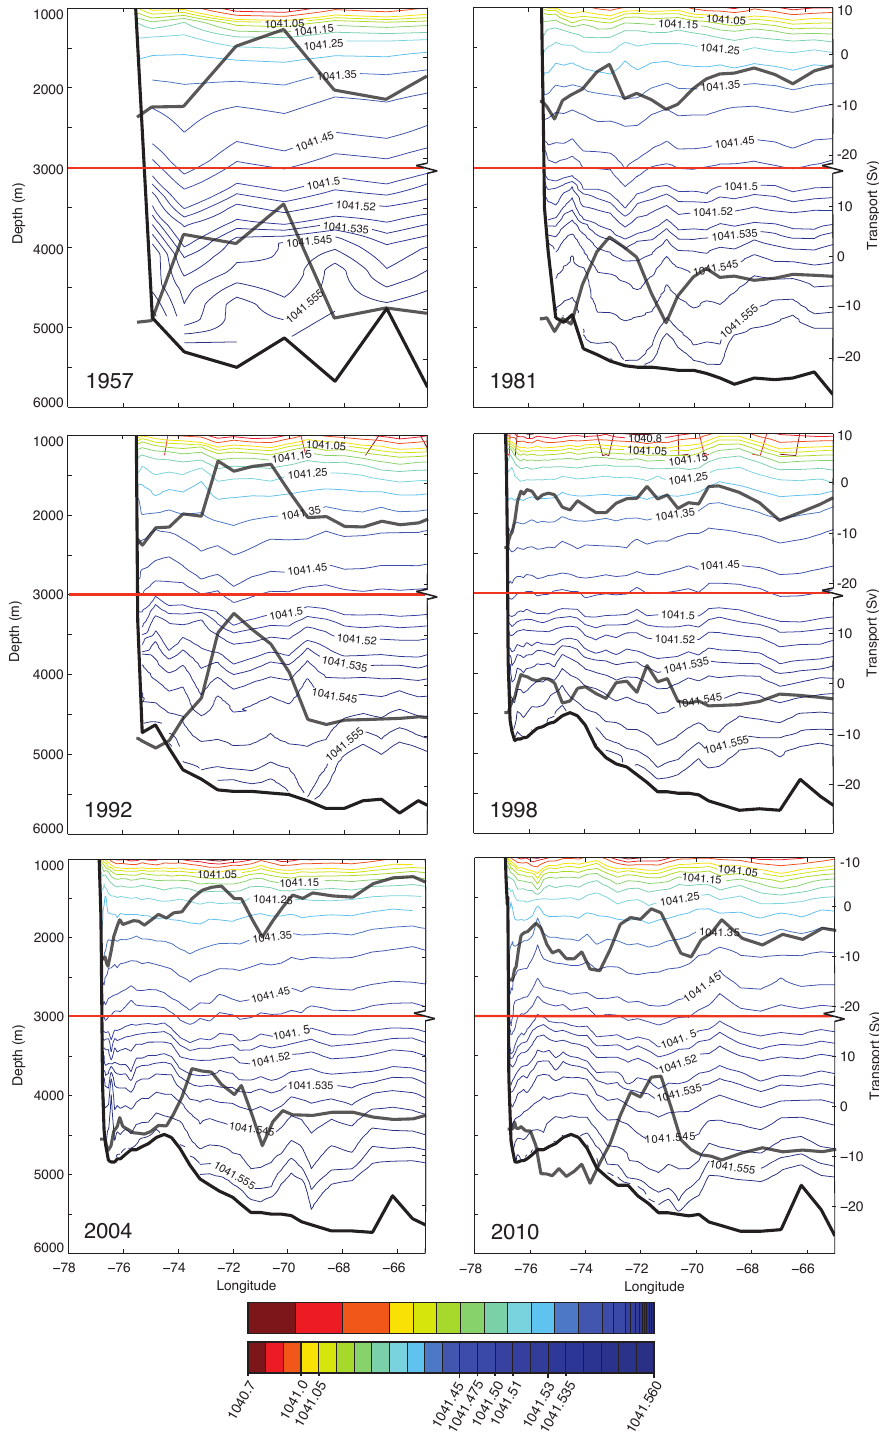
Fig. 14. Potential density ( σ 3 ) contour plots in the deep ocean at the western Atlantic margin for the six hydrographic sections. Note the nonlinear scale of density contours (lower colourbar; contour separation reduces with increasing depth, from 0.1 to 0.05, 0.025, 0.01 and 0.005kgm − 3 ). For emphasis, a linear colourbar is also included (upper colourbar). Overlain in grey are UNADW and LNADW cumulative transports from Fig. 9 (red horizontal line denotes the 3000m depth interval used to separate UNADW and LNADW in this